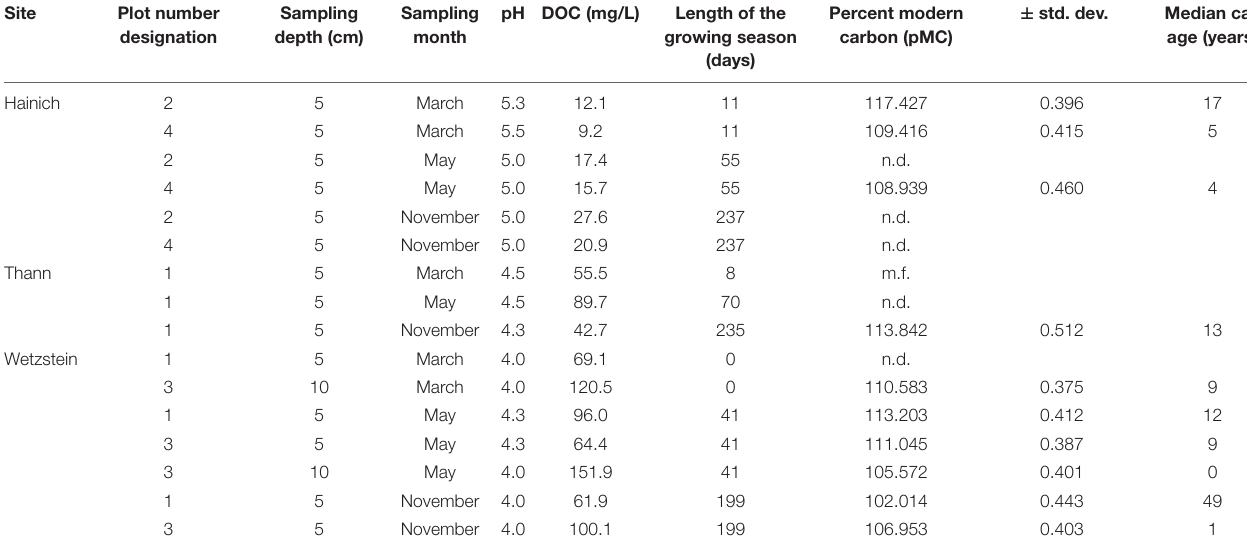
TABLE 1 | Overview of the sample sites regarding pH, DOC concentration, length of the growing season and radiocarbon ages of SPE-DOM. Site Plot number Sampling Sampling pH DOC (mg/L) designation depth (cm) month